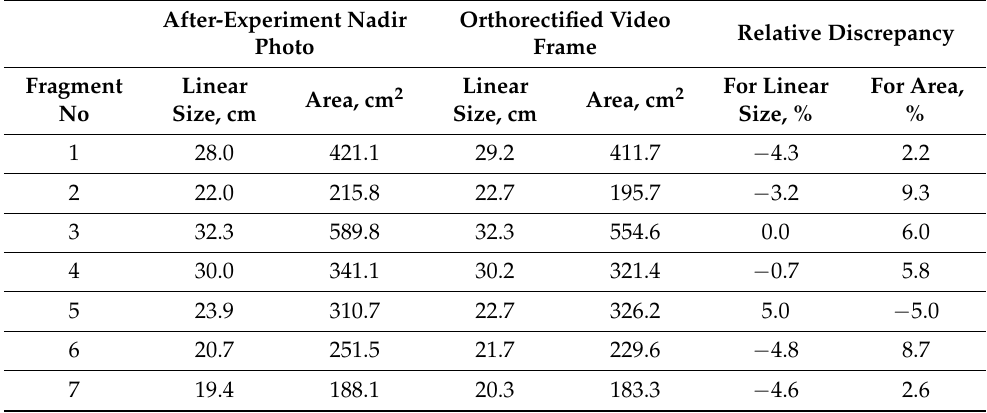
Table 2. Ice fragments characteristics retrieved from a video recording of the rubble pile and from the after-experiment nadir photo. After-Experiment Nadir Orthorectified Video Relative Discrepancy Photo Frame For Linear For Area, Linear Fragment Linear Area, cm 2 Area, cm 2 Size, % Size, cm No Size, cm